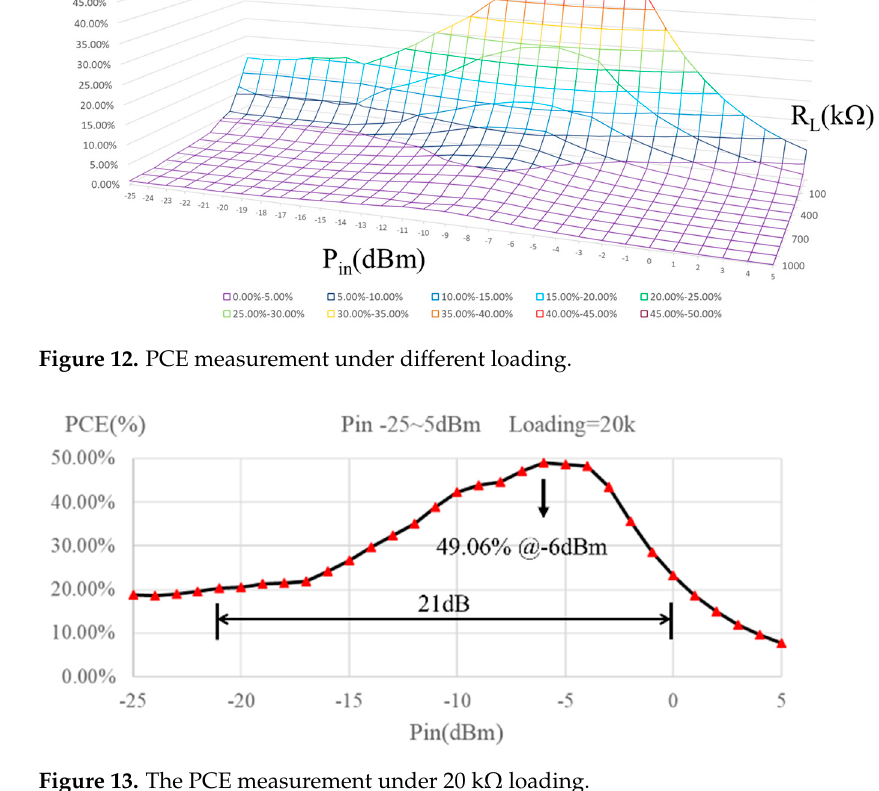
Figure 13. The PCE measurement under 20 k Ω loading.